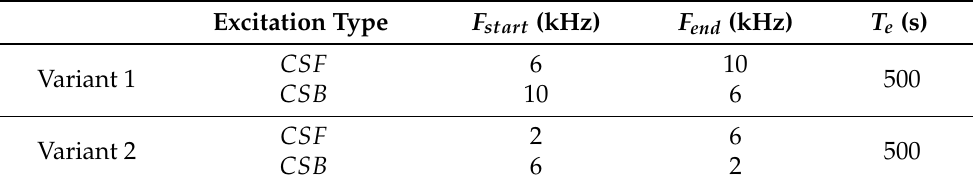
Table 2. Characteristics of the CS -type excitation